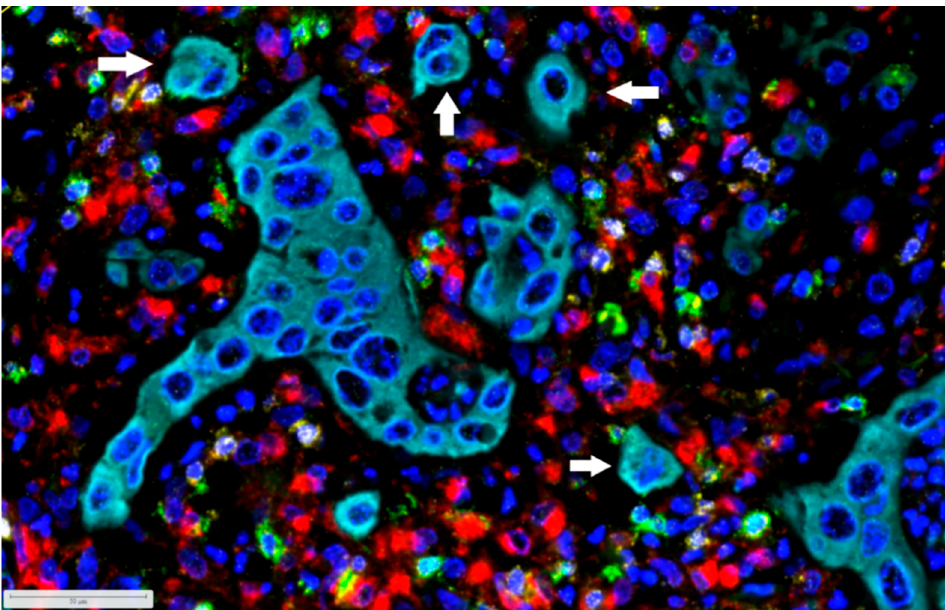
Figure 1. PDAC (pancreatic ductal adenocarcinoma) with Basal-like phenotype with presence of many tumor buds (arrows) and an immunosuppressive microenvironment with many CD68 + tumor-associated macrophages (TAMs) and few CD8 + and CD3 + T cells, many of which express FOXP3 (T regulatory cells; Tregs). Tumor cells (pancytokeratin): cyan; CD68 + TAMs: red; CD8 + T cells: green; CD3 + T cells: yellow; and FOXP3 + Tregs: white. DAPI (4',6-Diamidino-2-phenylindol): blue. Multiplex immunofluorescence ×300.